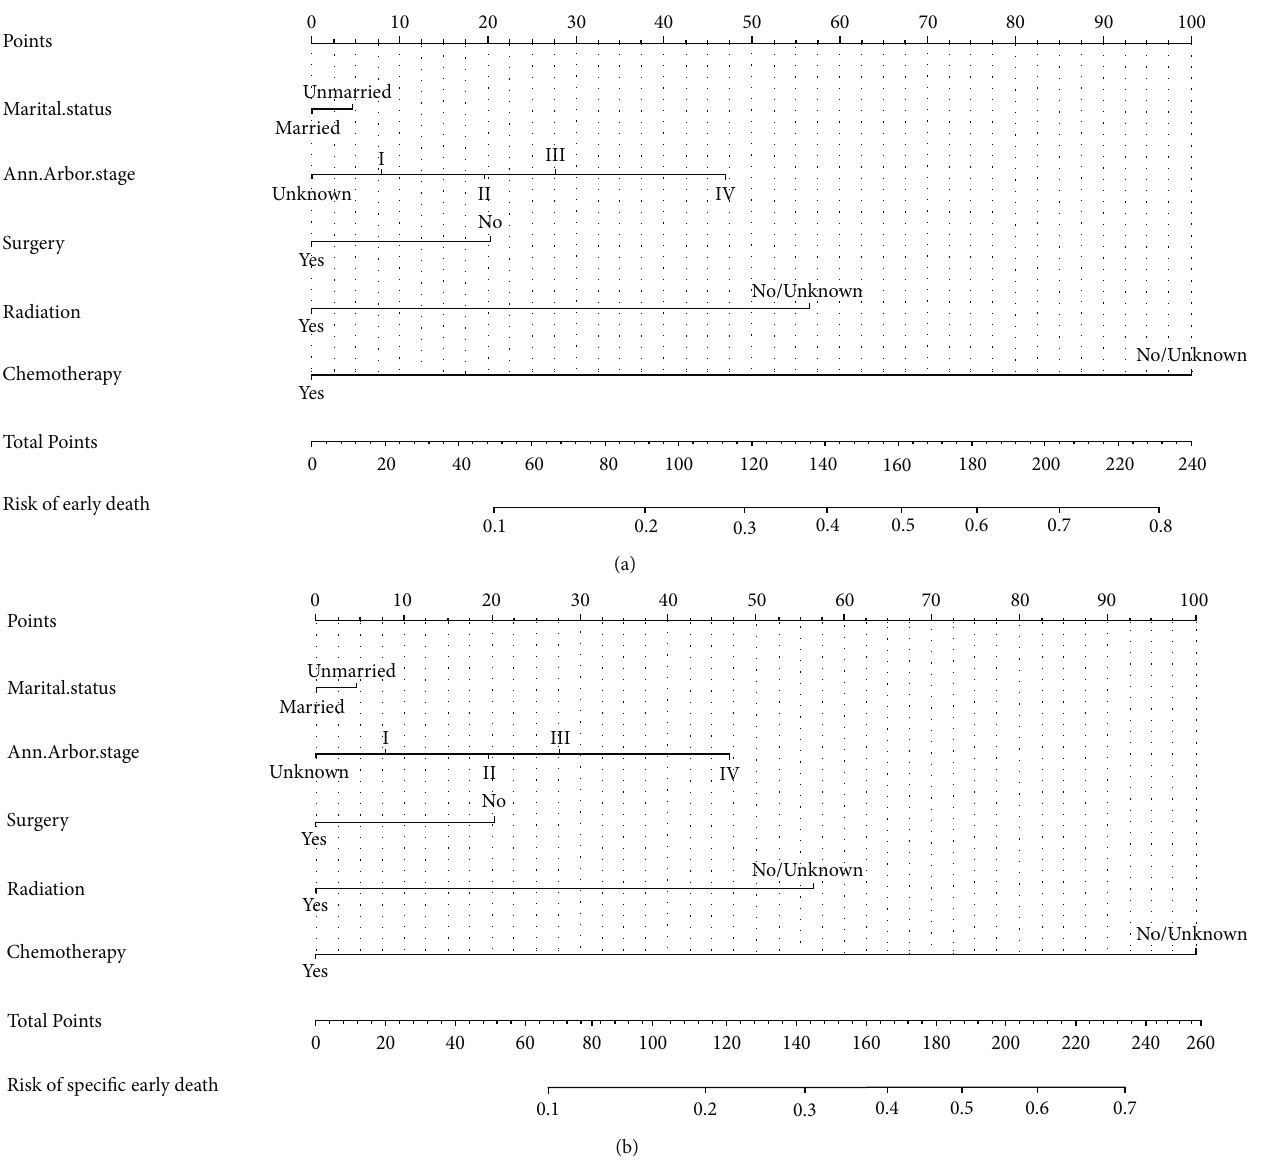
Figure 1: The predictive nomogram for the overall early death (a) and speci fi c early death (b) for DLBCL